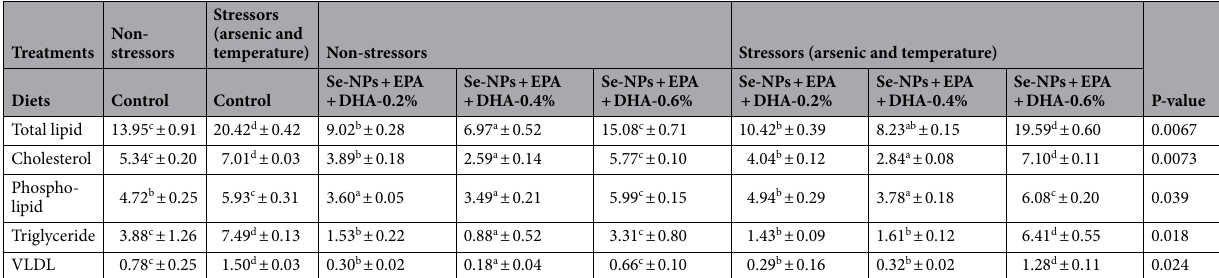
Table 6. Mitigation of secondary stress response (total lipid, cholesterol, phospholipid, triglyceride and VLDL) through dietary supplementation of selenium nanoparticles, eicosapentanoic acid and dicosahexanoic acid fed to P. hypophthalmus reared in control or under arsenic and high temperature for 105 days. Values in the same row with different superscript (a, b, c, d) differ significantly. Data expressed as Mean ± SE (n = 3). Total lipid; cholesterol; phospholipid; triglyceride; very low density lipoprotein (VLDL) mg dL −1 .